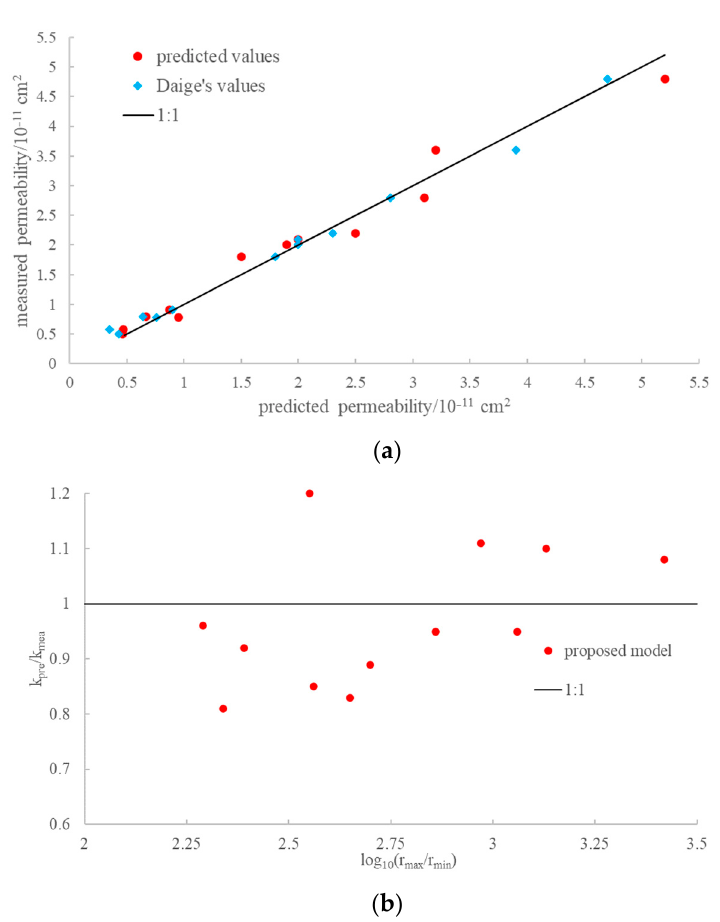
Figure 3. ( a ) Comparison of predicted permeabilities, measured values and existing predicted values. ( b ) Distribution of the ratio of predicted to measured permeabilities.